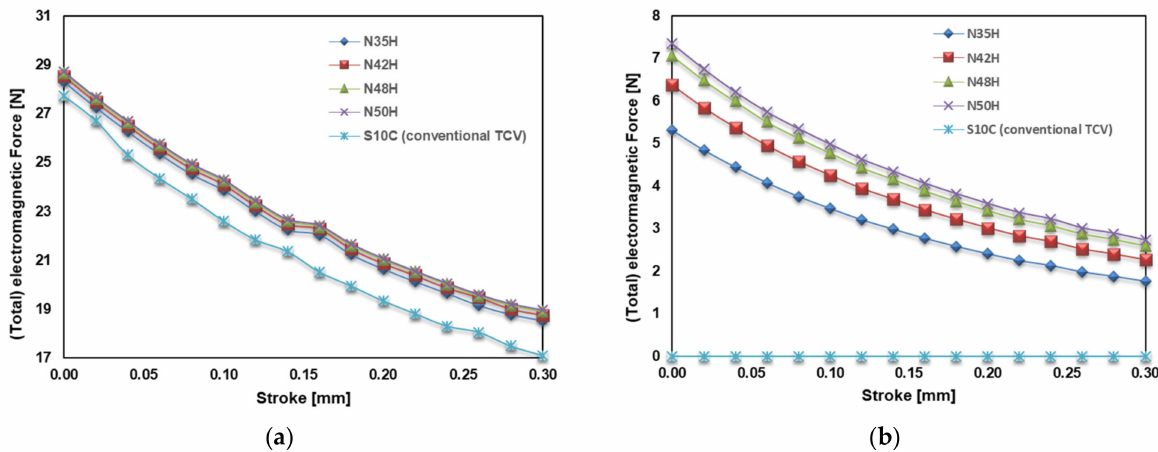
Figure 11. Total electromagnetic force for the permanent magnet specification: ( a ) total electromagnetic force for each stroke at 3.4 A; ( b ) total electromagnetic force for each stroke at 0